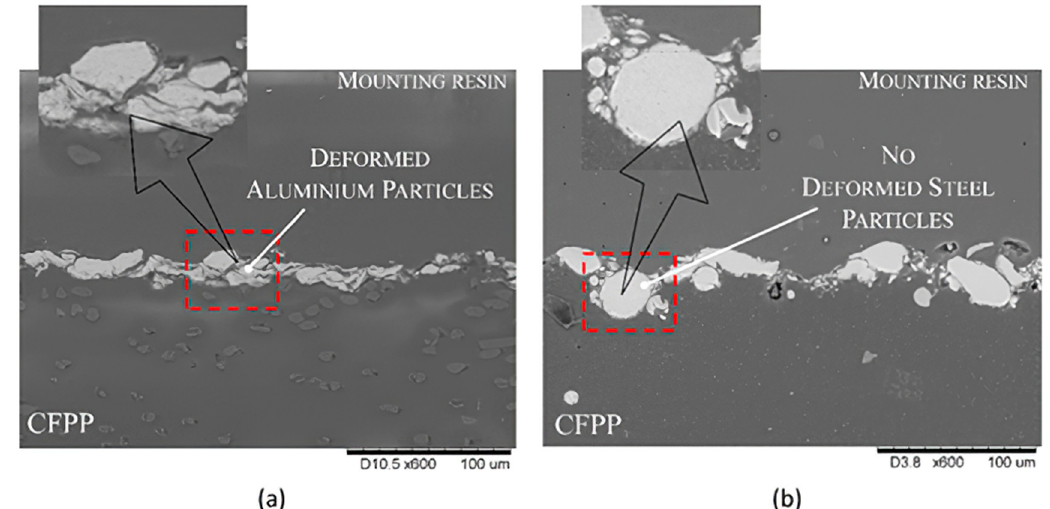
Figure 5. SEM micrographs of cross-sections of the specimens CFPP-Al 2 and CFPP-AISI 2 . ( a ) CFPP substrate with aluminium coating, ( b ) CFPP substrate with steel coating.